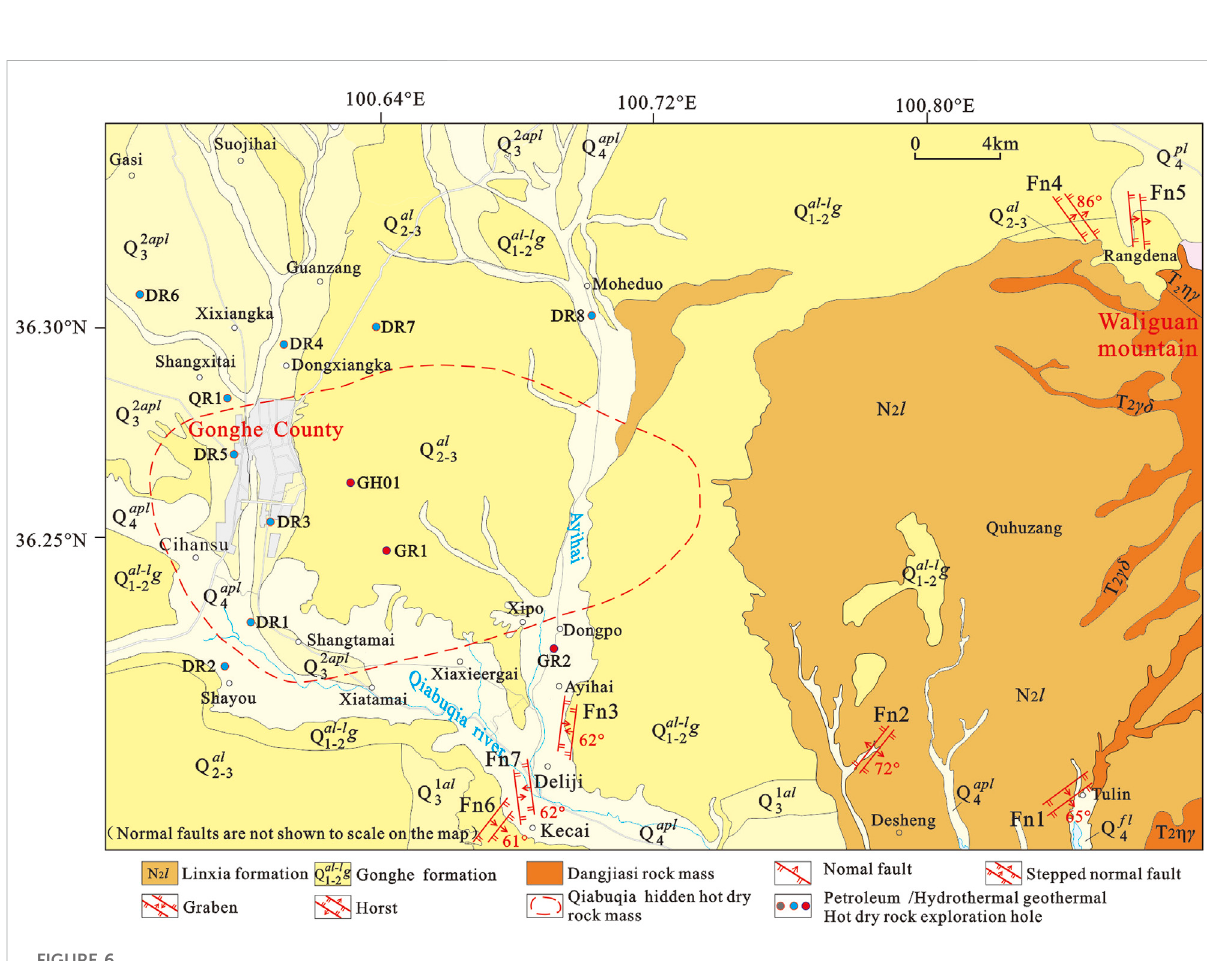
FIGURE 6 Distribution of normal faults in the Qiabuqia area (Area B in Figure